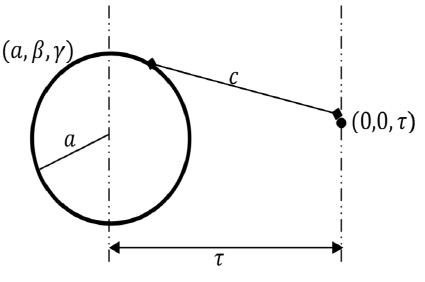
Figure 2. Schematic for a point interacting with a sphere of radius a . The Cis molecule is centered at ( 0, 0, τ ) , where τ is the perpendicular distance from the center of the drug molecule to the pore on the upper surface of the box, and H denotes the length of the box. The negative or positive sign of τ is determined as to whether the drug molecule is inside or outside the cylindrical pore. Further, a typical point on the surface of the cylindrical hole has the coordinates ( x , y , − z ) ≡ ( α cos φ , α sin φ , − z ) , where z ∈ ( 0, H ) , H denotes the length, α ∈ ( (cid:96) , ∞ ) , and (cid:96) is the radius of the pore. Thus, the distance c between the centre of the Cis drug and the surface element of the pore (cid:112) α 2 + ( τ + z ) 2 , and the integral K n is given by c =